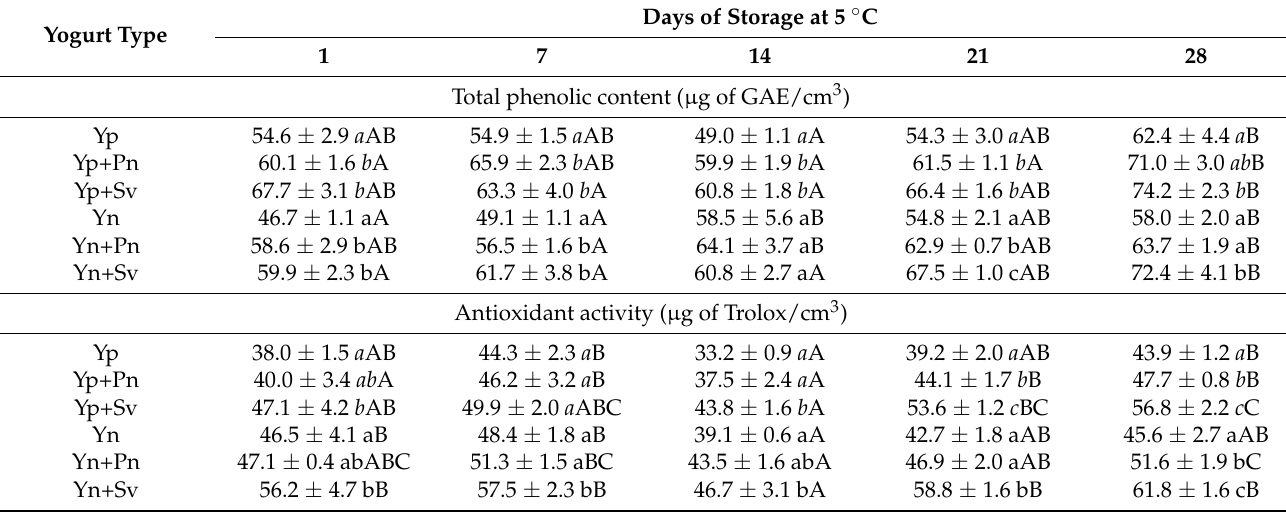
Table 4. Total phenolic content and antioxidant activity of probiotic (Yp) and natural (Yn) yogurt with or without scCO 2 /H 2 O extracts from P. nigra (Pn) and S. viminalis (Sv) during storage *. Yogurt